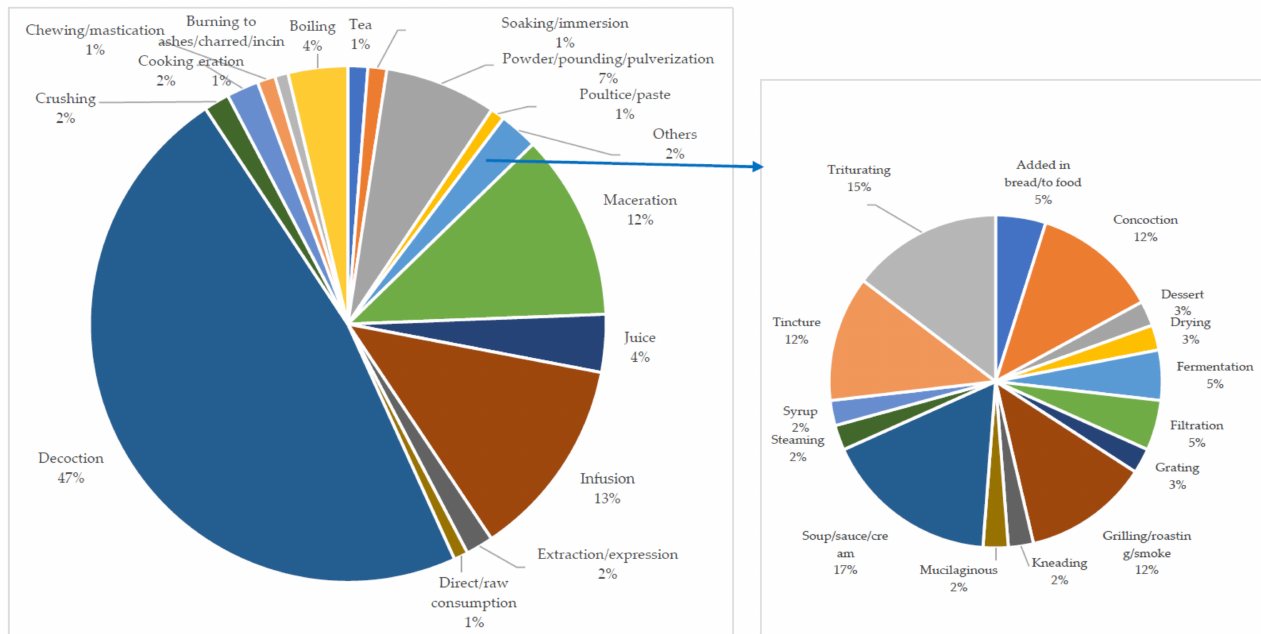
Figure 4. Percentage use of the different modes of preparation of medicinal plants for the treatment of cardiovascular diseases in sub-Saharan